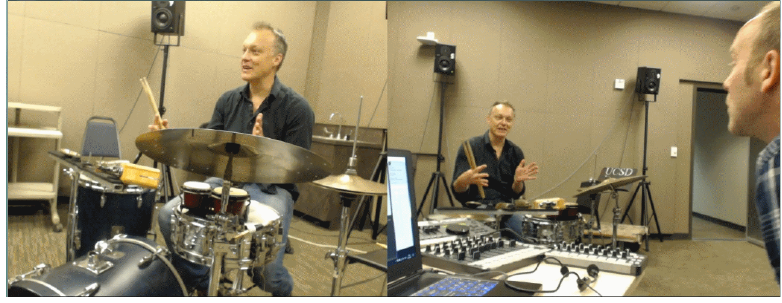
Figure 14. Kjell Nordeson and Øyvind Brandtsegg discussing live convolver